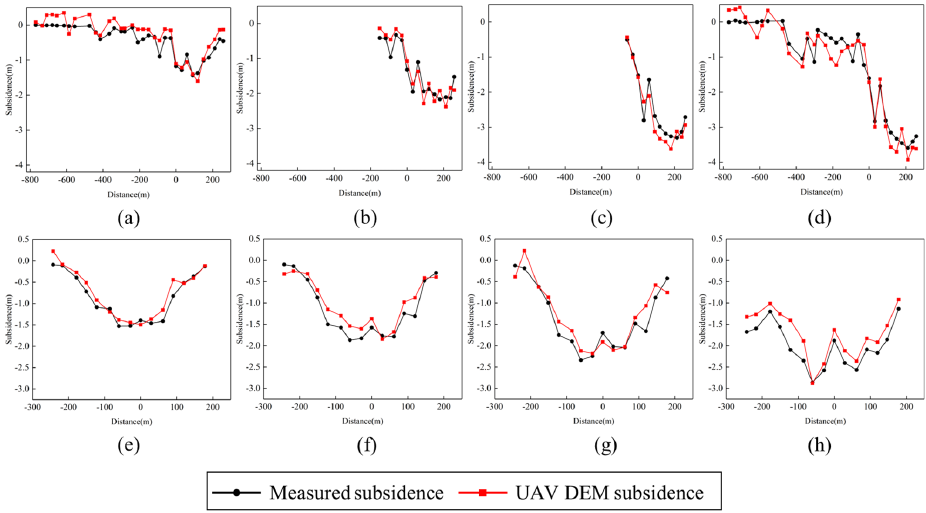
Figure 6. Comparison of subsidence values about the monitoring points: ( a ) line A 07.20 − 06.14; ( b ) line A 09.07 − 06.14; ( c ) line A 11.15 − 06.14; ( d ) line A 07.31 − 06.14; ( e ) line B 07.20 − 06.14; ( f ) line B 09.07 − 06.14; ( g ) line B 11.15 − 06.14; and ( h ) line B 07.31 − 06.14.